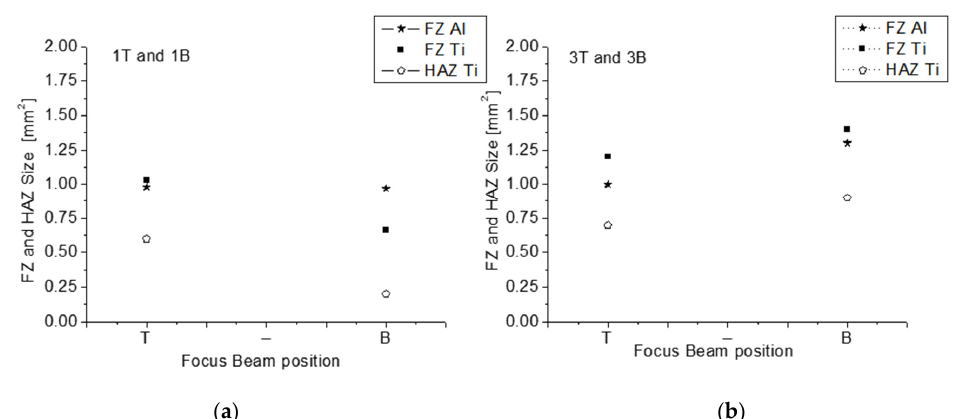
Figure 6. FZ and HAZ size for joints 1T and 1B ( a ) and joints 3T and 3B ( b ). Considering both focused (T) and defocused beam (B), the joints 1T and 1B ( a ) are characterized by a lower size of the FZ with respect to joints 3T and 3B ( b ).